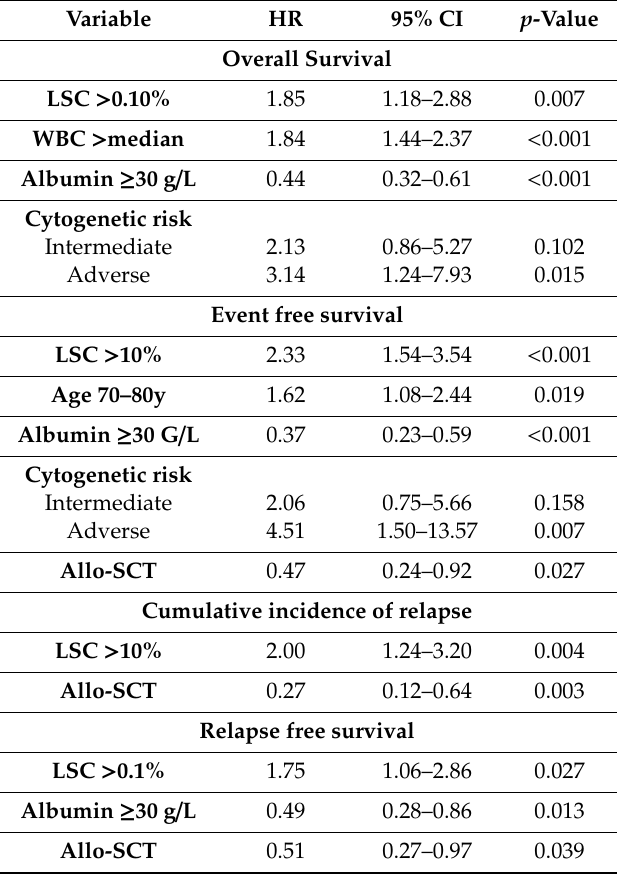
Table 4. Multivariate analyses for OS, EFS, CIR, and RFS in patients treated by intensive chemotherapy. Variable HR 95% CI p